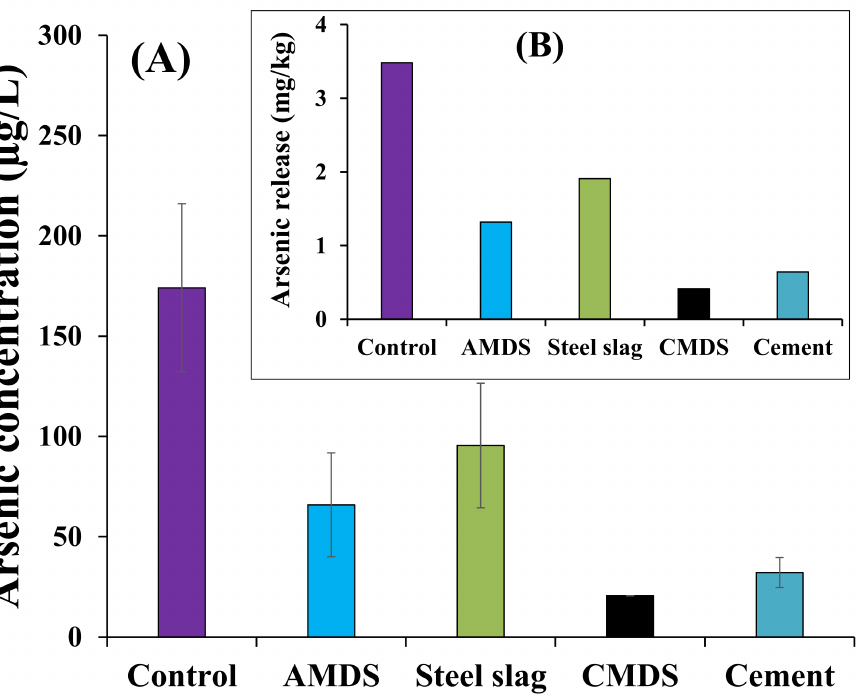
Figure 7. Leaching of arsenic from contaminated (control) and stabilized soils using the TCLP test, ( A ) leachate concentration (as µ g/L); and ( B ) release of arsenic (as mg/kg) from different stabilized